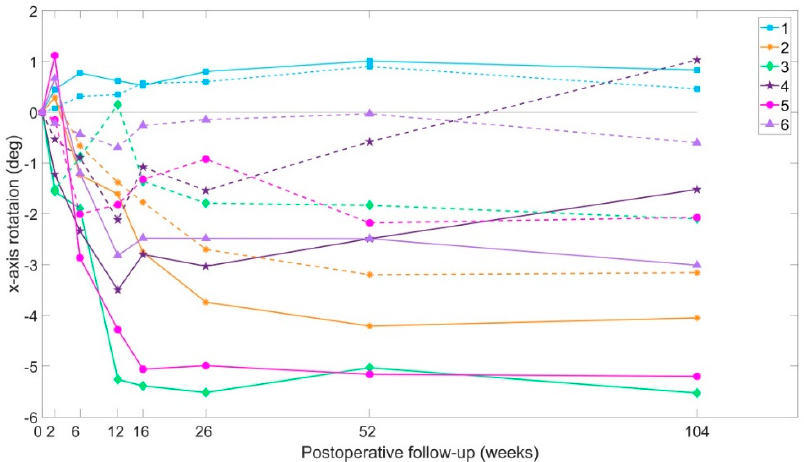
Figure 6. X-axis rotations over time. Positive values report anterior rotation (flexion) of the ilium against the sacrum, and negative values report posterior rotation (extension). Continuous lines indicate displacements of the injured side ilium. Dotted lines indicate displacements of the non-injured side ilium.